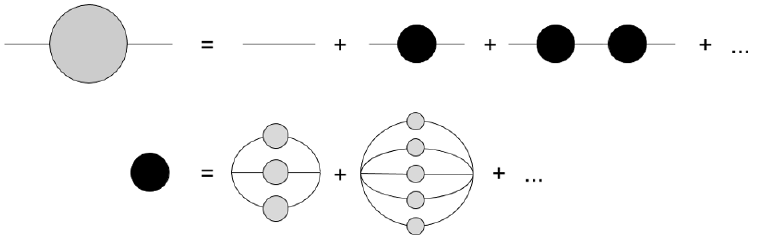
Figure 1 . The diagrammatic representation of the Schwinger-Dyson equations. The grey circle represents the full two point function and the black circle represents the one particle irreducible